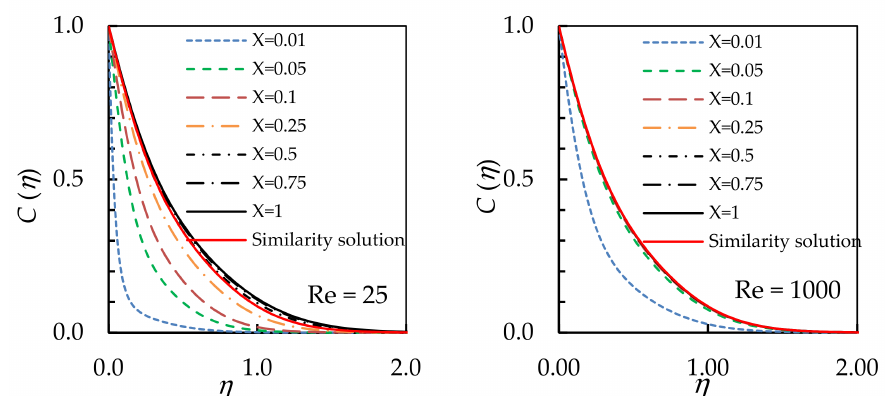
Figure 5. Effect of the Reynolds number on the profile of the concentration of the nanoparticles at various locations along the sheet for Gr = 10 4 , Pr = 6.2, Le = 10, Nb = Nt = Nr = Rb = Ω = 0.1, and Pe = Lb = 1.